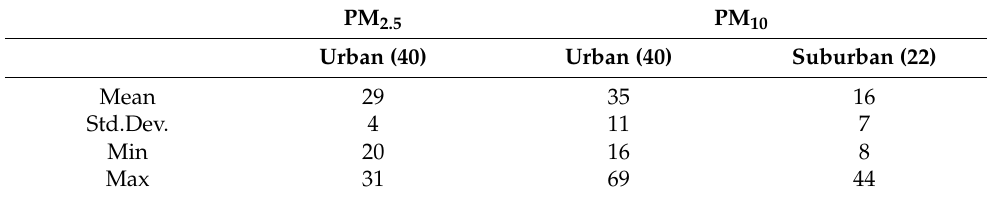
Table 1. Characteristics of PM 10 and PM 2.5 samples at the three monitoring stations. Mass - concentrations expressed in μ g m − 3 . The number of samples for each monitoring station is shown in brackets. PM 2.5